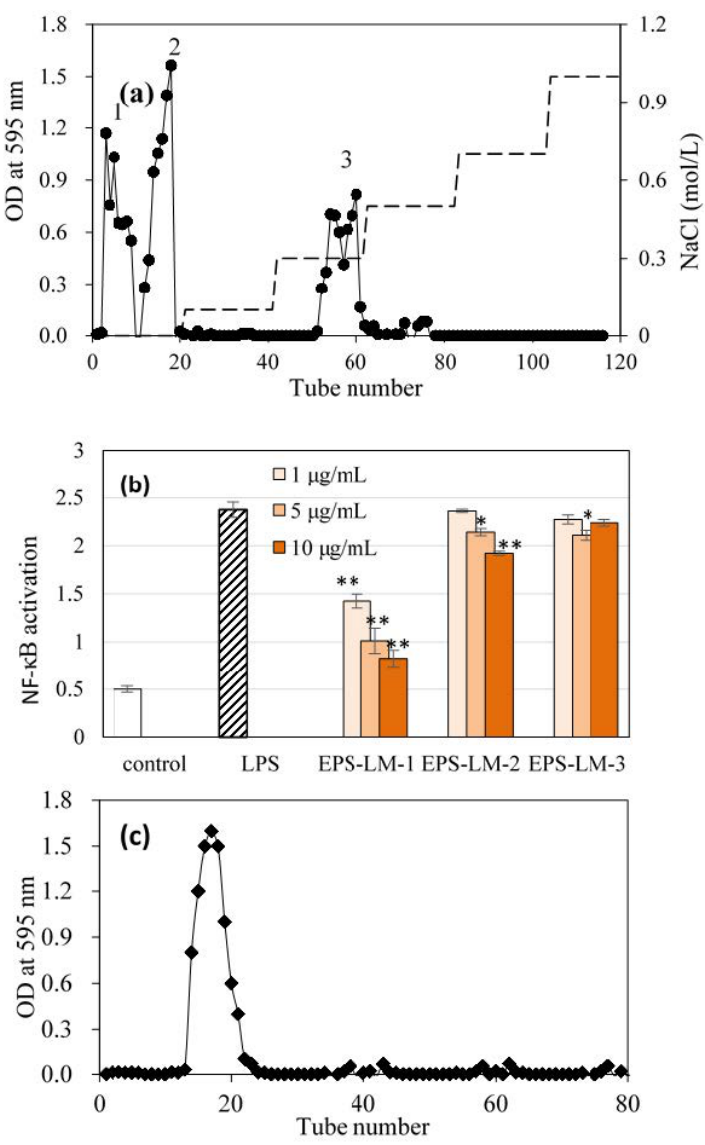
Figure 2. Purification and anti-inflammatory activity of EPS-LM fractions: ( a ) fractionation of EPS-LM by anion exchange on a DEAE-Sepharose column (0.1 M NaCl elution; Peaks 1, 2, and 3 representing the EPS-LM-1, -2, and -3 fractions, respectively); ( b ) anti-inflammatory activity test on EPS-LM fractions: effect on LPS-induced NF- κ B activation in THP-1 cell culture (* and ** indicate statistically significant differences from the LPS group at p < 0.05 and p < 0.01 by the Student t -test, respectively); ( c ) GPC spectrum of EPS-LM-1 eluted from a preparative Sephadex 200 pg